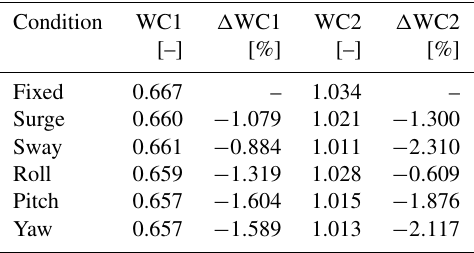
Table 5. Average wake deficit for the rotor area for the two wind conditions WC1 and WC2 and different motions at the wave fre- quency. (cid:49) is the percent change with motion with respect to the fixed